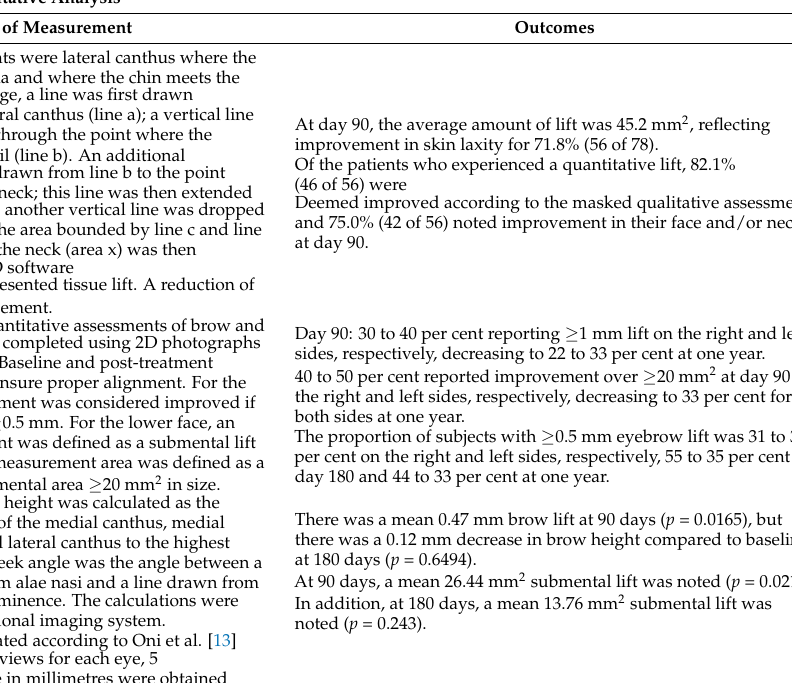
Table 3. Quantitative analysis of MFU effects on facial skin tightening. Effects on brow lift, submental lift and marionette line lift. Quantitative Analysis Method of Measurement